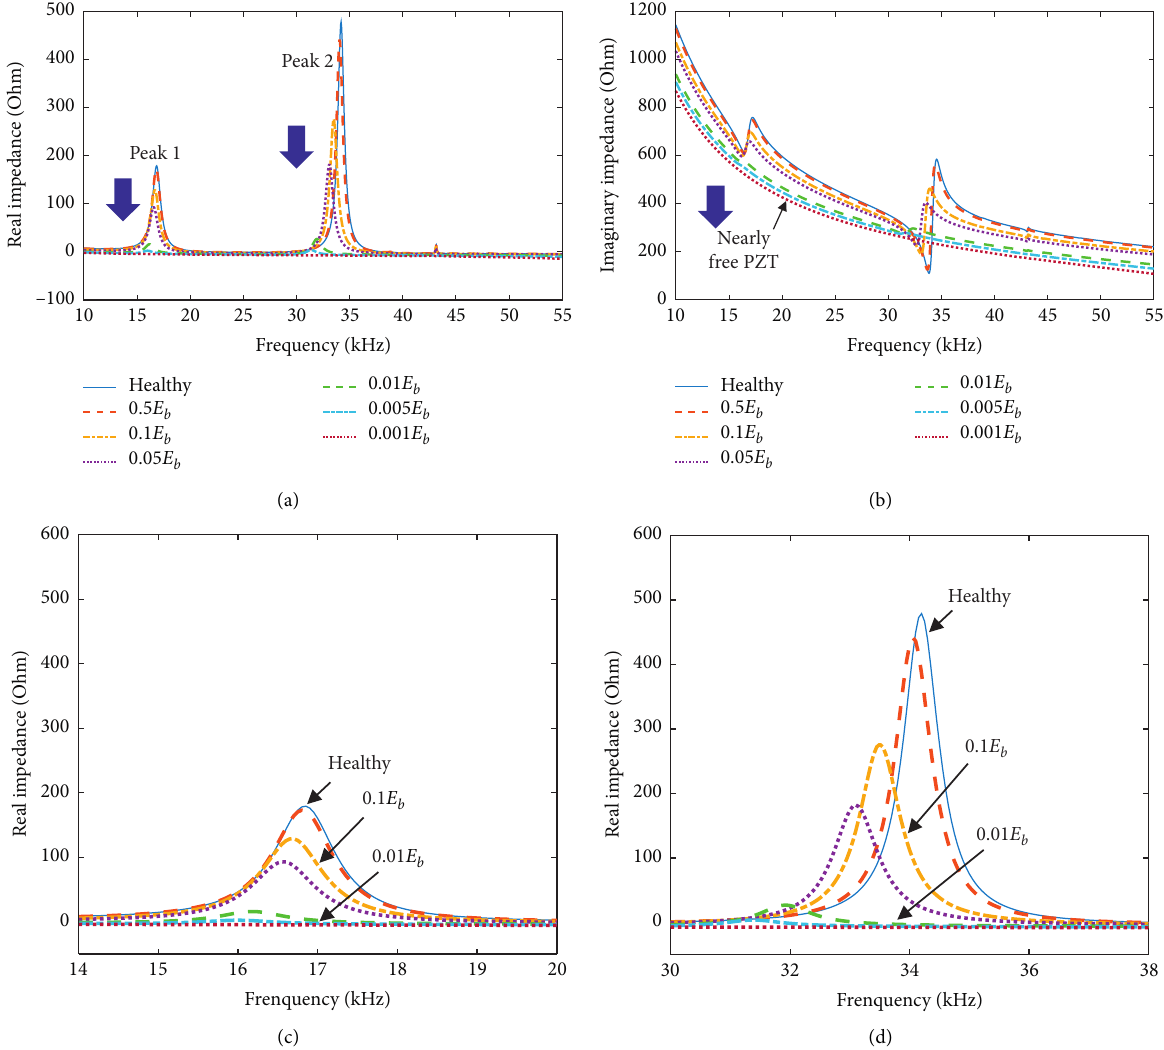
Figure 15: Numerical EMI responses under the shear lag effect. (a) Real part. (b) Imaginary part. (c) Peak 1. (d) Peak 2. 00.20.40.60.81